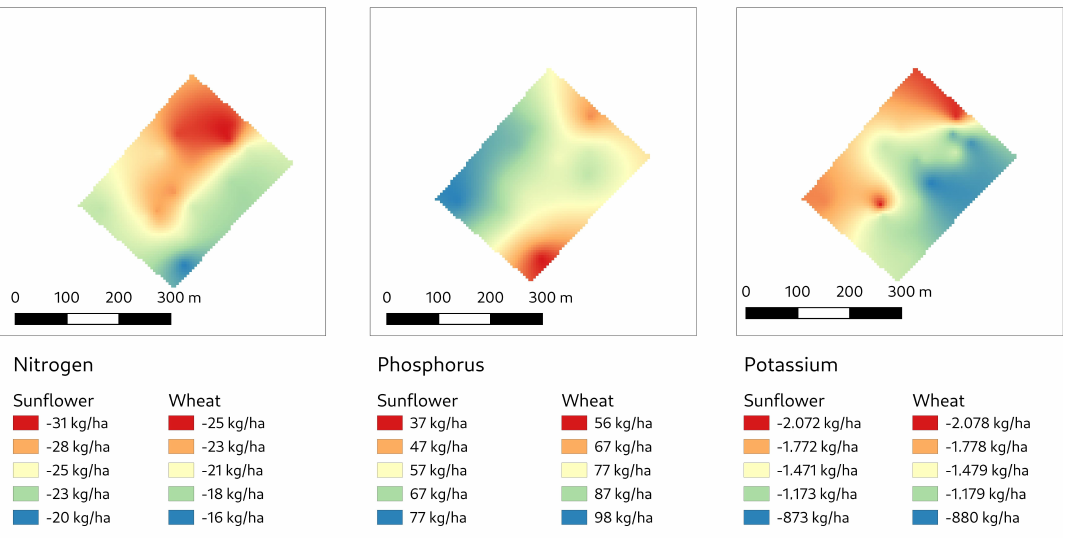
Figure 7. Spatialized fertilization plans for the three main macronutrients for sunflower and wheat crops: from left-most panel to right-most panel: nitrogen, phosphorus, and potassium. Excess nutrient concentration in soil is shown in negative figures (the lower concentration the more excess of nutrient), whereas a demand for nutrient is shown in positive figures (the higher concentration the more demand for